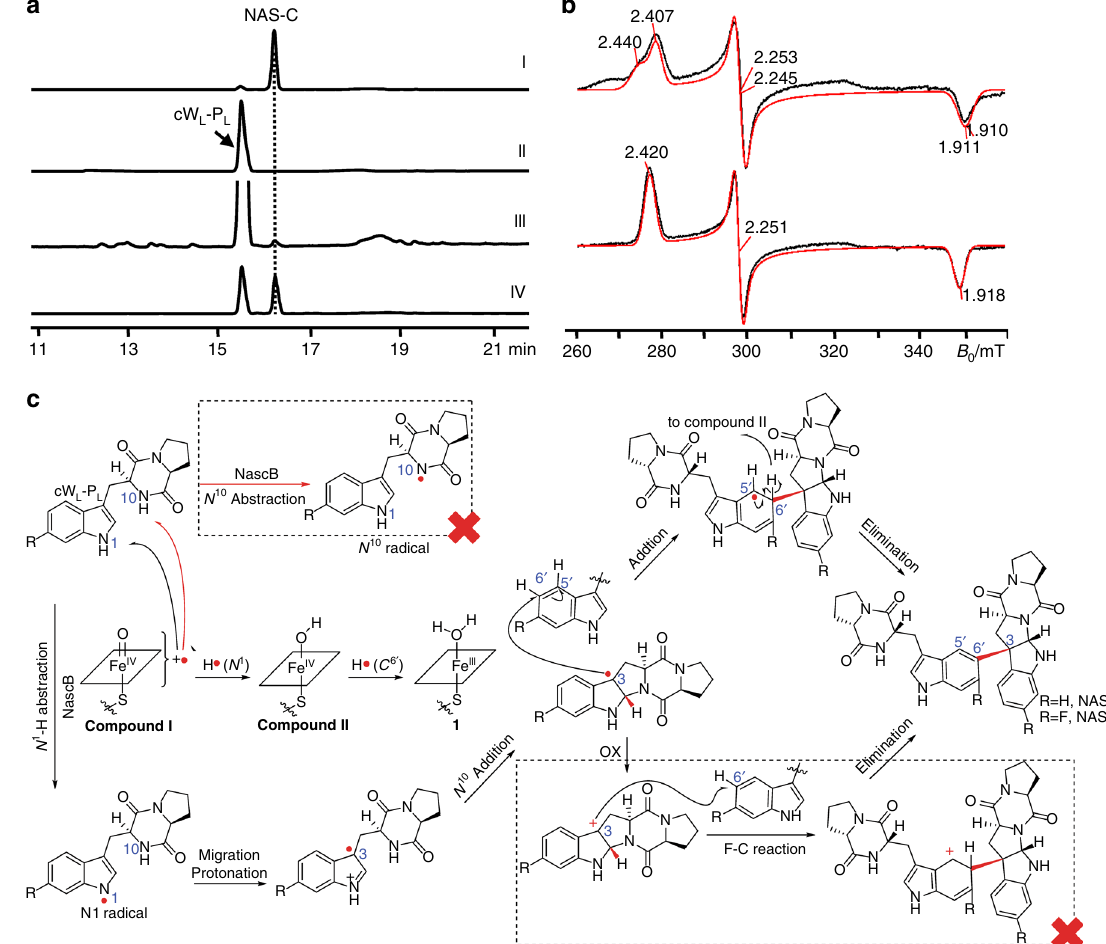
Fig. 3 Characterization of NascB in vitro and the proposed mechanism. a HPLC analysis of the NascB-catalyzed reaction. (I) Standard NAS-C, (II) a control reaction, the same as NascB reaction but only omitting the P450 NascB, (III) NascB reaction, using E. coli Fdx and FdxR as electron supply system, (IV) NascB reaction, using spinach Fd and FdR as electron supply system. b X-band (9.3810 GHz) CW EPR spectra recorded at 15 K showing the low-spin (LS) ferric heme signal in the absence (the upper panel) and presence (the lower panel) of the substrate (twofold excess of cW L -P L ). Simulations computed using the principal g -values are shown in red: (the upper panel) two component model with g = (2.407, 2.253, 1.911) and g = (2.440, 2.245, 1.910); (the lower panel) single component model, g = (2.420, 2.251, 1.918). c Proposed mechanisms of the radical-mediated intramolecular cyclization and intermolecular addition reaction by NascB. The NascB mechanism is proposed to involve the active species compound I (Fe IV = O + (cid:129) ) 24 – 26,34 . It abstracts a proton with an electron from the HN 1 of the substrate to form the active species compound II (Fe IV (-OH)), which is further converted into the ferric species ( 1 ) by accepting a hydrogen radical from C6 ′ position of the substrate to form one water molecule. The water coordination turns NascB into the resting state P450, completing the catalytic cycle 12,35 . A signi fi cant high Gibbs free energy ( △ G ) calculated by DFT calculation rule out the possibility of N 10 radical (marked by a dashed rectangle with a red cross). The possibility of Friedel – Crafts reaction from pyrroloindoline C 3 -radical was ruled out by the insensitivity of NascB-catalyzed reaction to the electron-withdrawing group introduced at C 7 -position of the